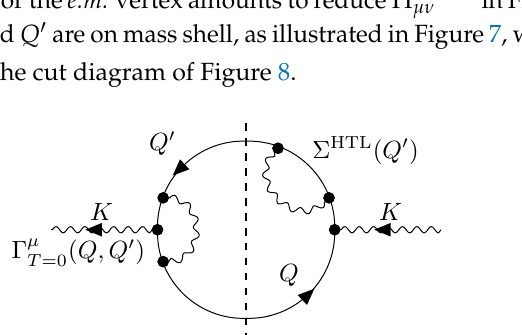
Figure 7. A contribution to the imaginary part of the polarization tensor Π ( 3 ) . Cut lines Q and Q (cid:48) are on mass shell.